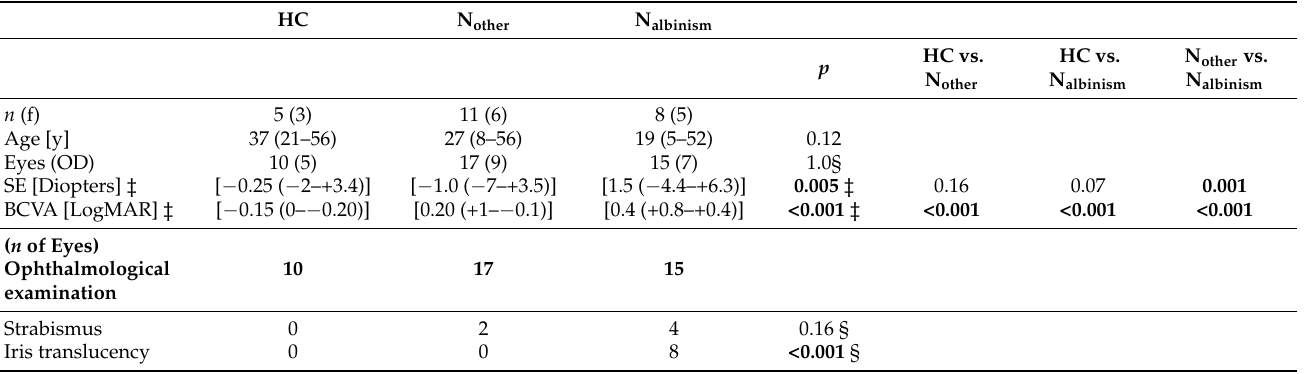
Table 2. Studied groups’